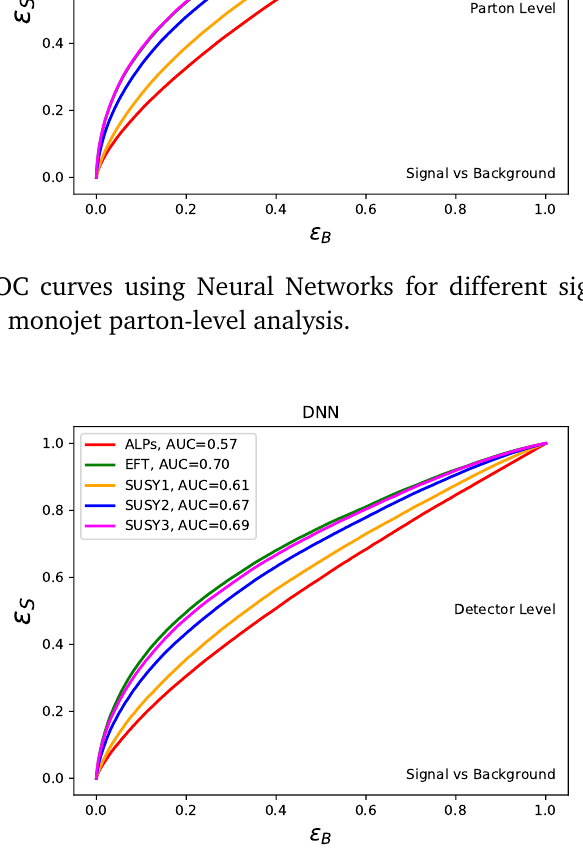
Figure A4: ROC curves using Neural Networks for different signals versus back- ground for the monojet detector-level simulated